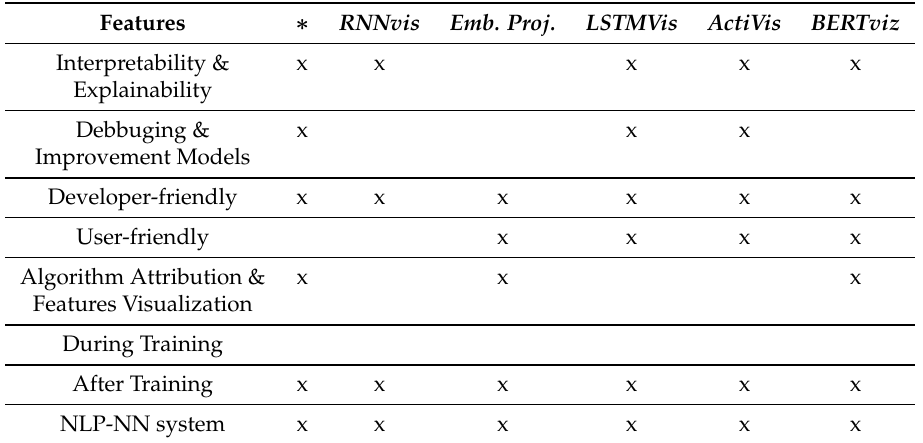
Table 1. Summary of representative visualization tools for natural language processing (NLP)-neural network (NN) systems. ∗ our